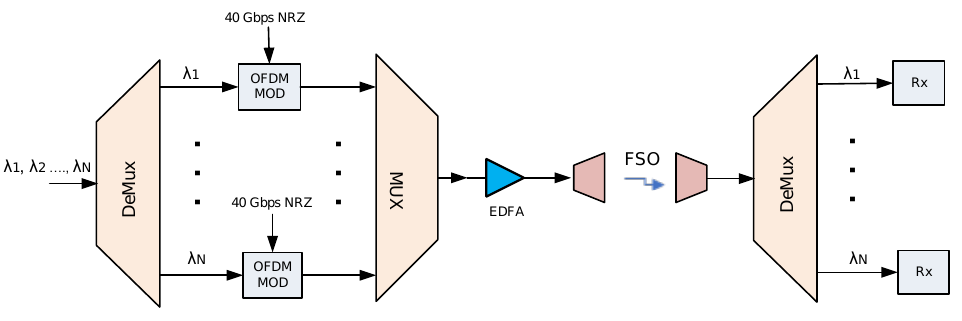
Figure 1. The WDM FSO architecture. A bidirectional WDM FSO system can be achieved by replicating the original topology for upstream transmission. However, a wavelength reuse scheme can be employed to reduce the cost since there is no optical source needed for upstream transmission. These systems maximize wavelength utilization by using the same wavelength for upstream and downstream channels. Downstream wavelength signals are remodulated with upstream data and then sent back as upstream signals [38,39]. The wavelength reuse scheme has been widely employed in WDM-PONs based on the RSOA, which can be used as an uplink colorless transmitter and modulator, thanks to its properties of optical gain, integration capability, and wide optical bandwidth [40]. Figure 2 depicts a bidirectional FSO WDM system based on a wavelength reuse scheme. It is similar to the original topology shown in Figure 1. The difference is that the demultiplexed WDM signals at the receiver side are passed through 3 dB optical splitters, where half of the WDM-OFDM modulated signal is fed to an OFDM receiver. For up-link, the other half of the downstream modulated signal is directly remodulated by the RSOA to generate the 10 Gbps NRZ OOK PRBS 2 23 − 1 upstream signal. As the seeding power of an RSOA has a significant effect on its modulation characteristics, a variable optical attenuator (VOA) is used to keep the power at the input of RSOA at a level in which it operates in the gain–saturation regime. The OOK signals generated are combined using a Mux and then launched back via an FSO channel to form upstream data, where they are separated by a DeMux, and each OOK signal is directly detected by a PIN receiver.